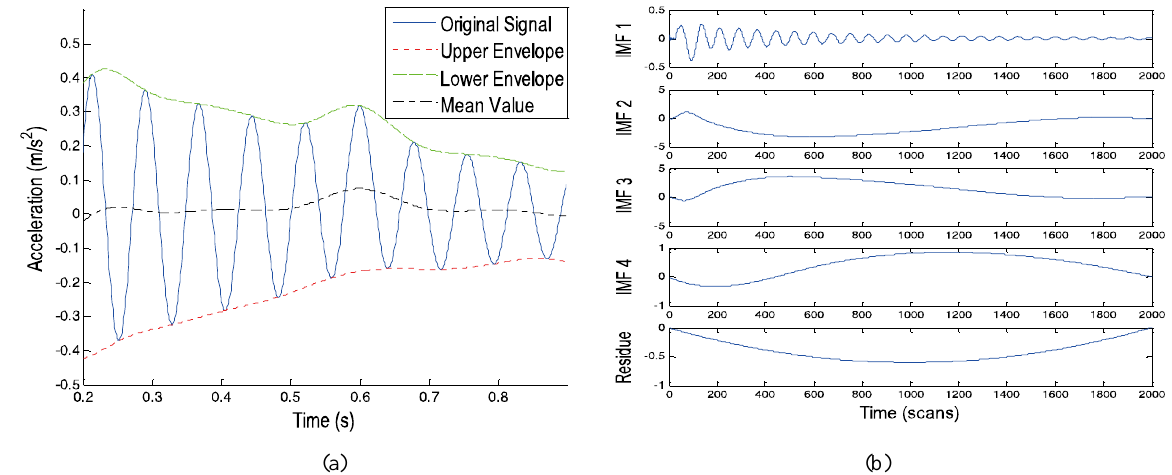
Fig. 1. (a) Construction of upper and lower signal envelopes and their mean value, (b) IMF plots of acceleration